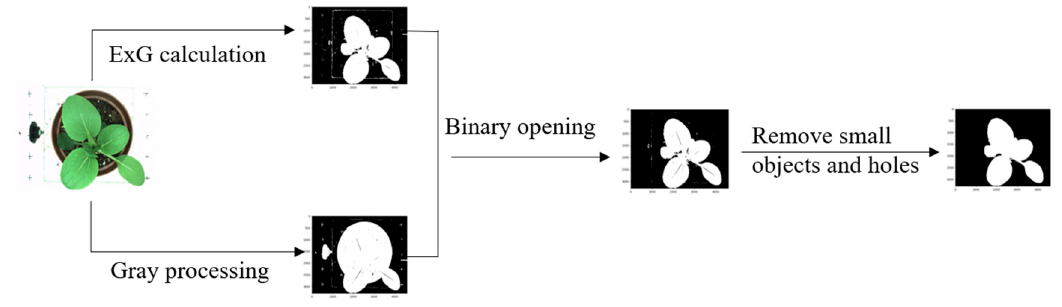
Figure 2. Image processing flow.